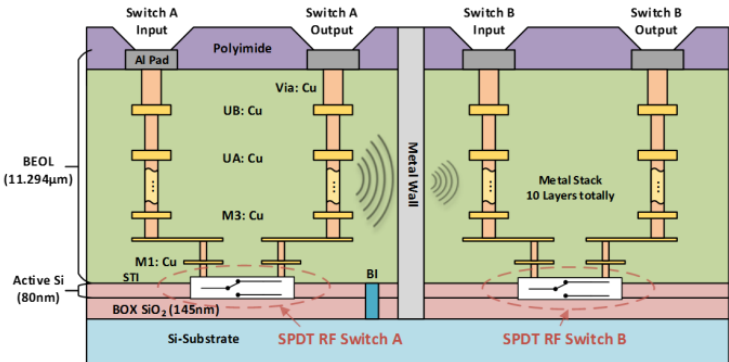
Figure 10. Cross-section view of the in-BEOL metal wall flying crosstalk isolation structure illustrated in SOI CMOS [35].